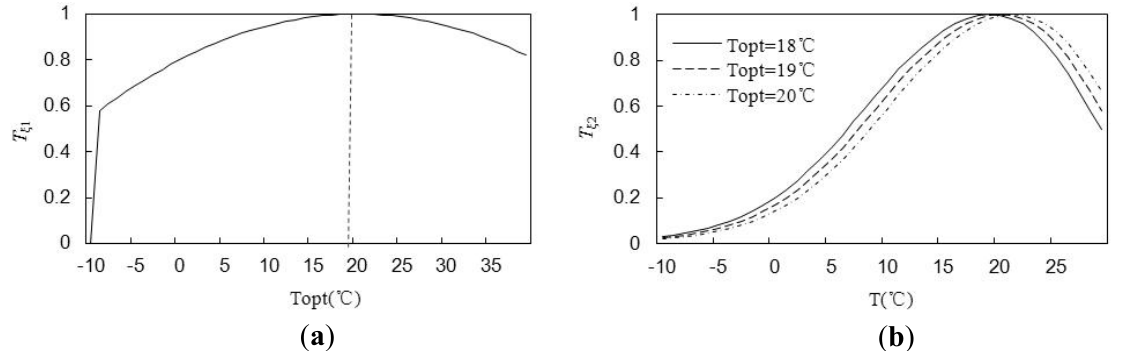
Figure 8. Curves of temperature stress on LUE in the CASA model, which is derived according to the equations in the literature [26,54]. ( a ) shows the inhibition effects of photosynthesis, determined by the internal biochemical actions under a certain temperature, in which Topt is the optimum temperature for plant growth; ( b ) represents the decreasing tendency of plant LUE when the ambient temperature changes from the optimum temperature Topt to a higher or lower